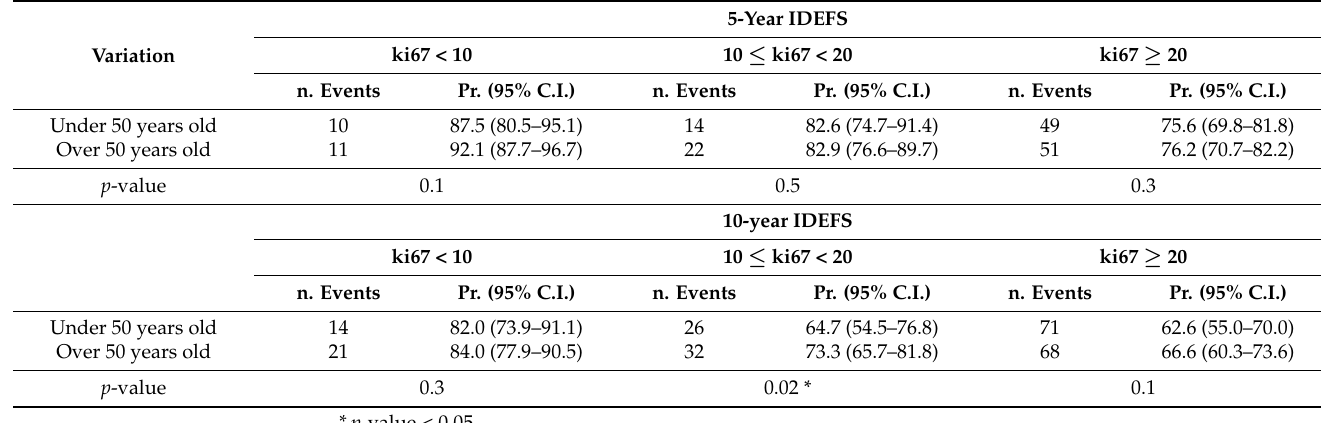
Table 2. Values of 5-year and 10-year IDEFS of patients under 50 years old and over 50 years old stratified into three samples with reference to two different thresholds of the cellular marker for proliferation ki67. The p -values resulting from the statistical analysis highlight a statistically significant difference between 10-year IDEFS probabilities of patients under 50 years old and over 50 years old.